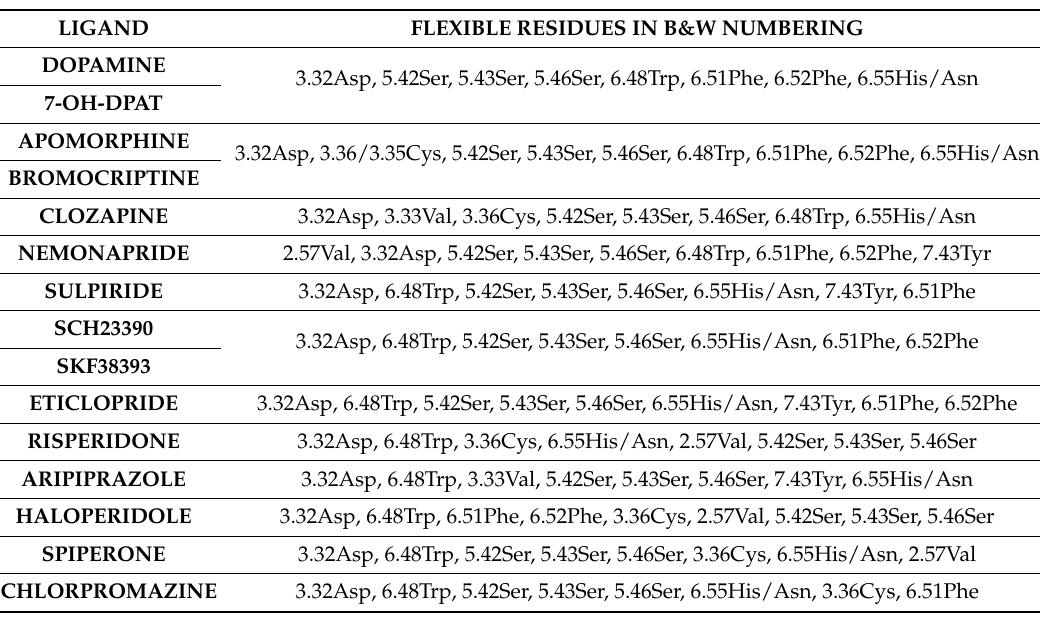
Table 4. Flexible residues used in the molecular docking different ligands.